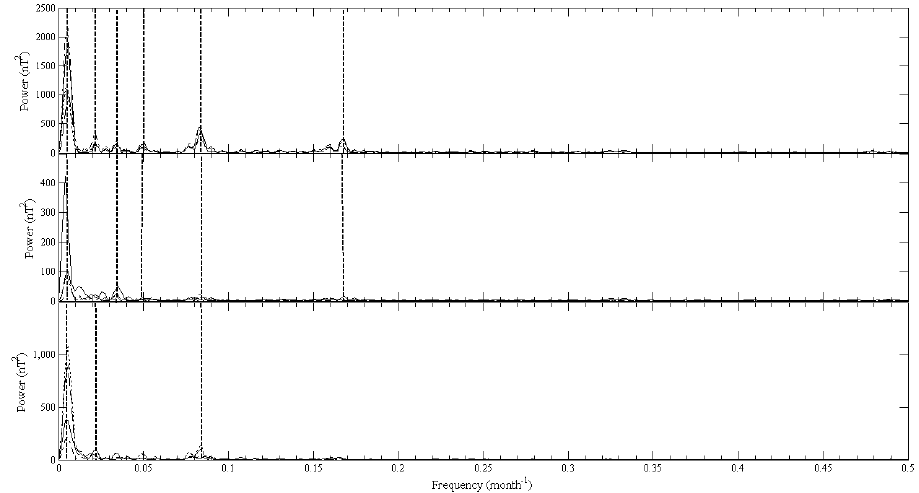
Figure 16. Power spectrum of X, Y, Z - components of external contribution (EMM model) at different observatories: NGK (dotted line), FUR (dashed line) KAK (dash-dotted line) and HER (solid line).